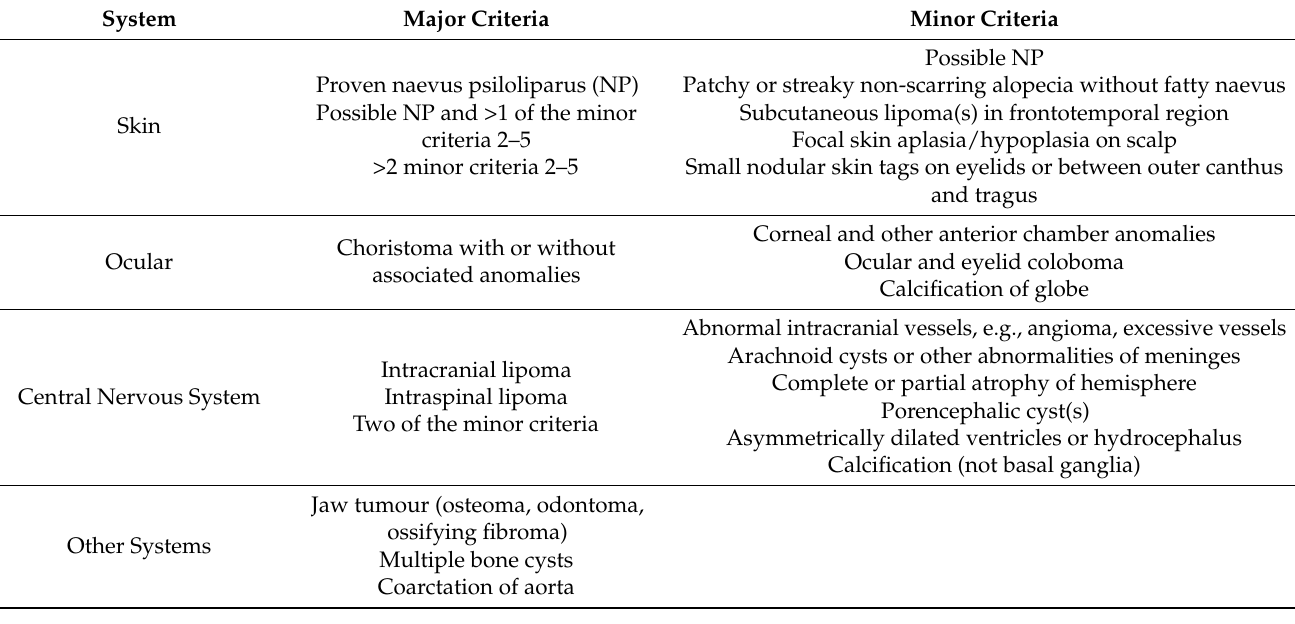
Table 1. The diagnostic criteria proposed by Hunter for the ECCL and modified by Moog [2,17].